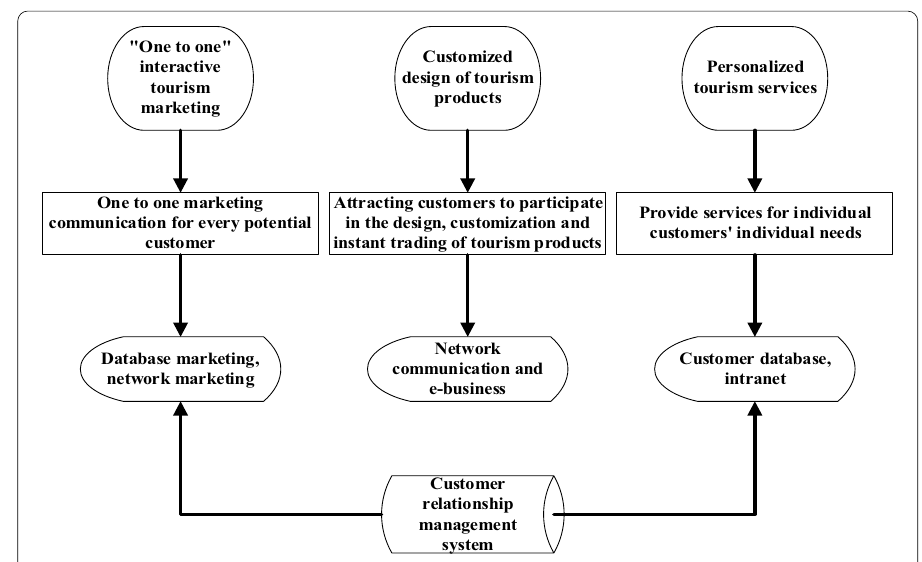
Fig. 5 Application of one-to-one tourism service system and electronic commerce